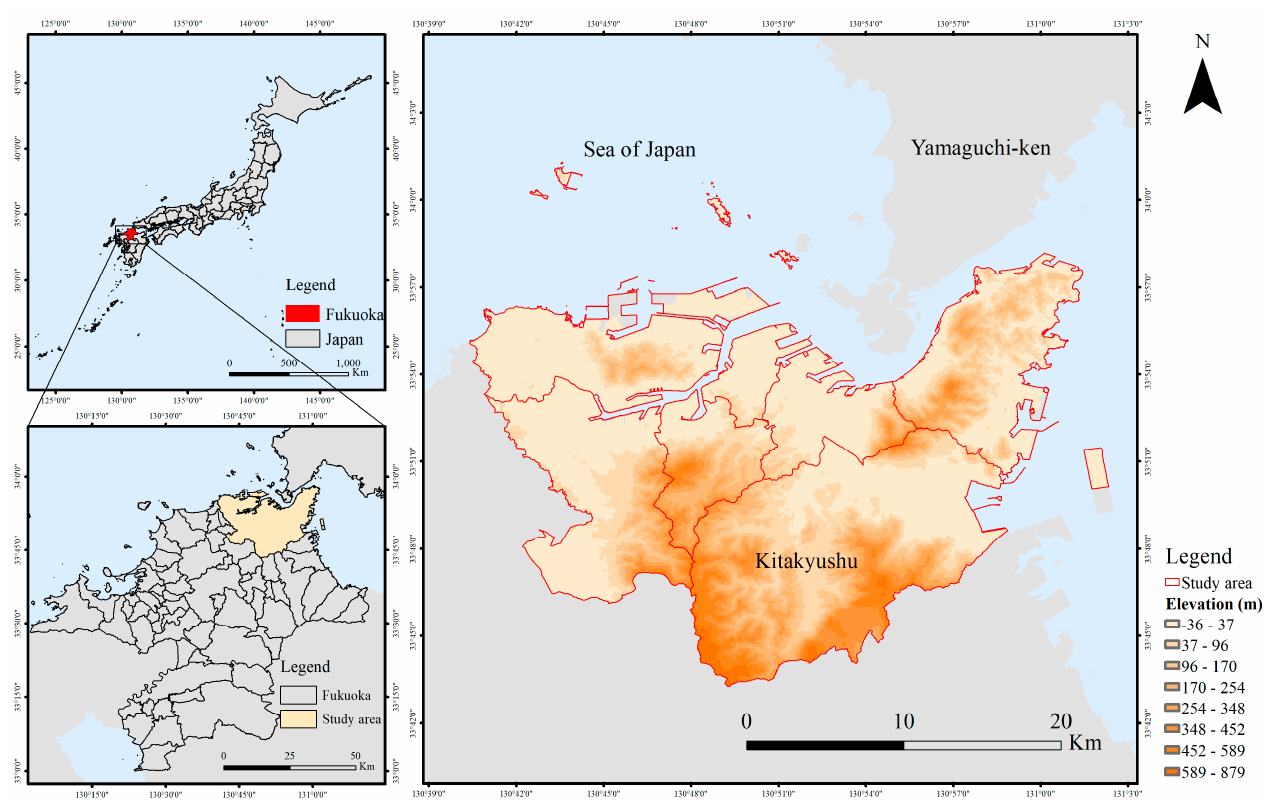
Figure 2. Location of the study area.